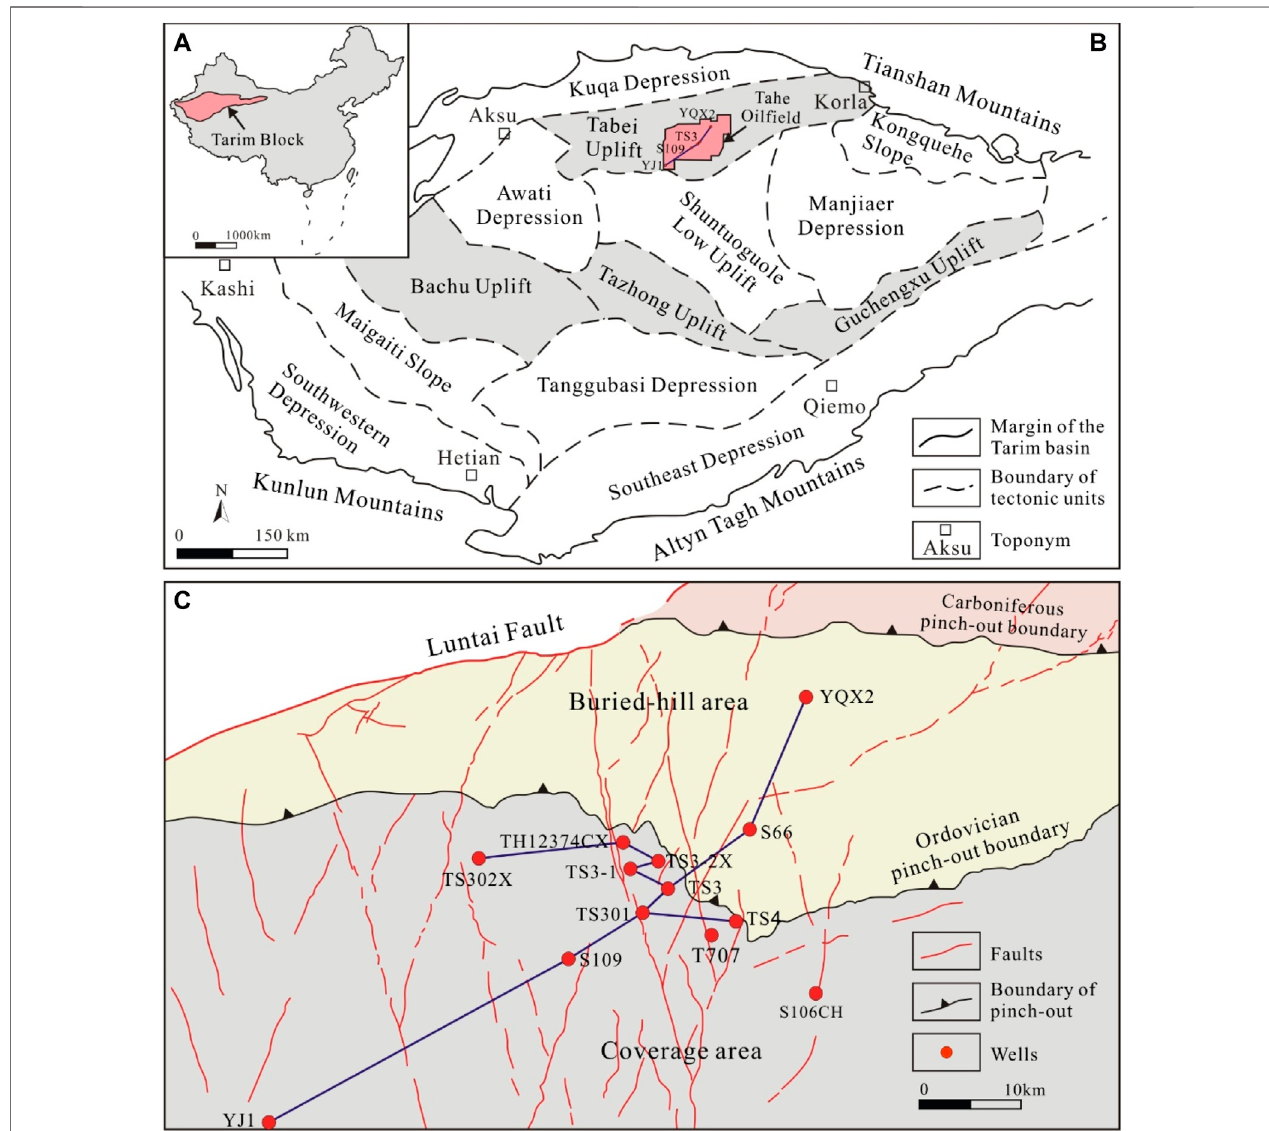
FIGURE1| (A) The location oftheTarimBasin inChina. Thered area signi fi estheTarimBasin. (B) The location ofthe TaheOil fi eldin theTarimBasin. The red area indicates the Tahe Oil fi eld. (C) The location of the wells and faults in the Tahe Oil fi eld. The gray area indicates the coverage area in the Tahe Oil fi eld. The yellow and red areas indicate the buried-hill